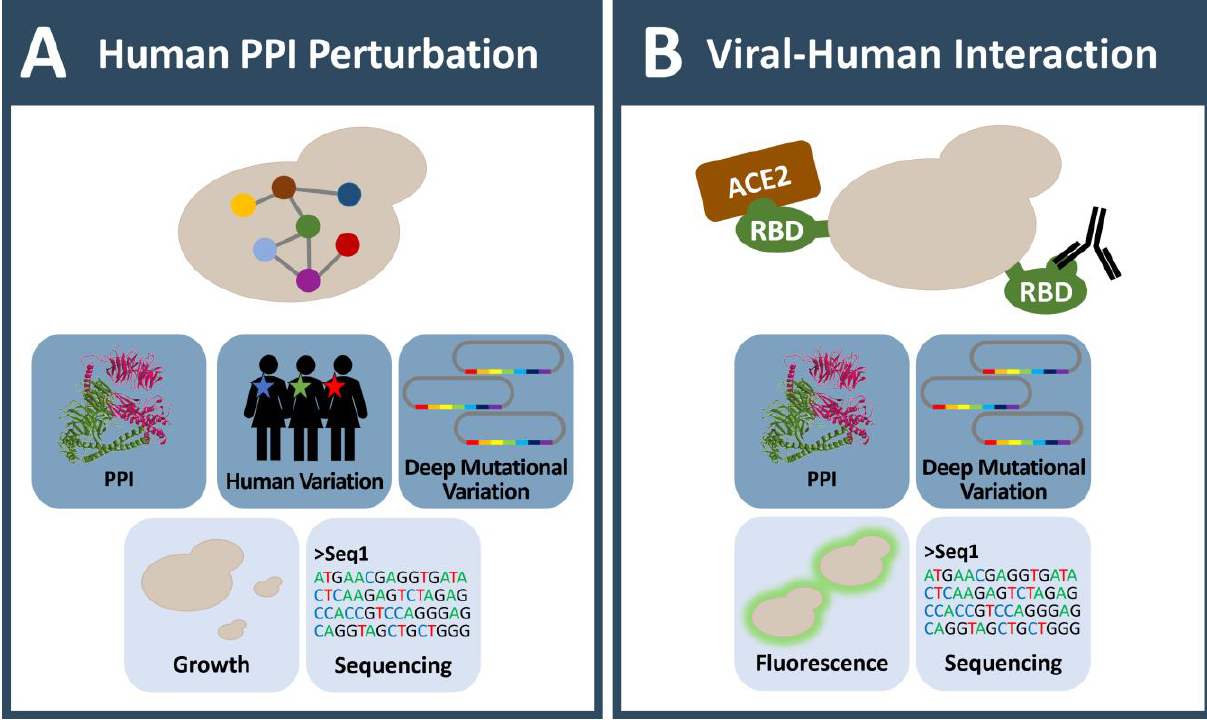
FIGURE 3: Yeast systems involved in large scale protein-protein interaction studies in the context of human coding variation and disease. (A) Yeast is used to investigate the influence of human coding variation systematically at large scale. As protein-protein interaction is a uni- form functional feature of all proteins, it is especially useful to uncover the influence of variants on protein-protein interaction and conse- quently its potential impact in disease. (B) As a quickly adaptive tool, yeast is currently also used in COVID-19 research. Deep mutagenesis on the SARS-CoV-2 spike protein receptor binding domain (RBD) was performed to characterize mutant variants in human ACE2 receptor and antibody binding. (A-B) Icons with dark blue background: observable; Icons with light blue background: readout; MS: mass spectrome- try; PPI: